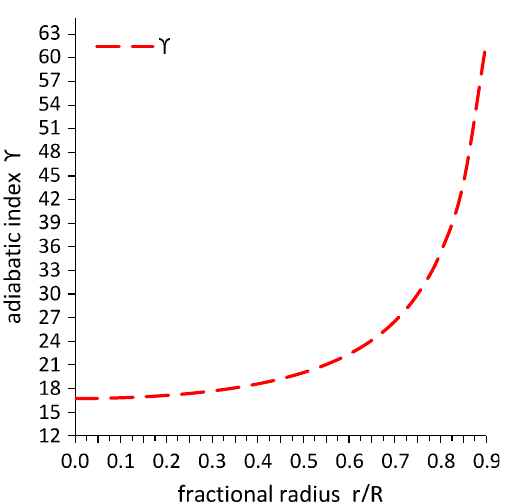
Fig. 6 Plot for the energy conditions with respect to the fractional radial distance ( r / R ) for RX J 1856-37. For plotting of this figure we have employed the same data set of numerical values as used in Figs. 1, 2, 3, 4 and 5